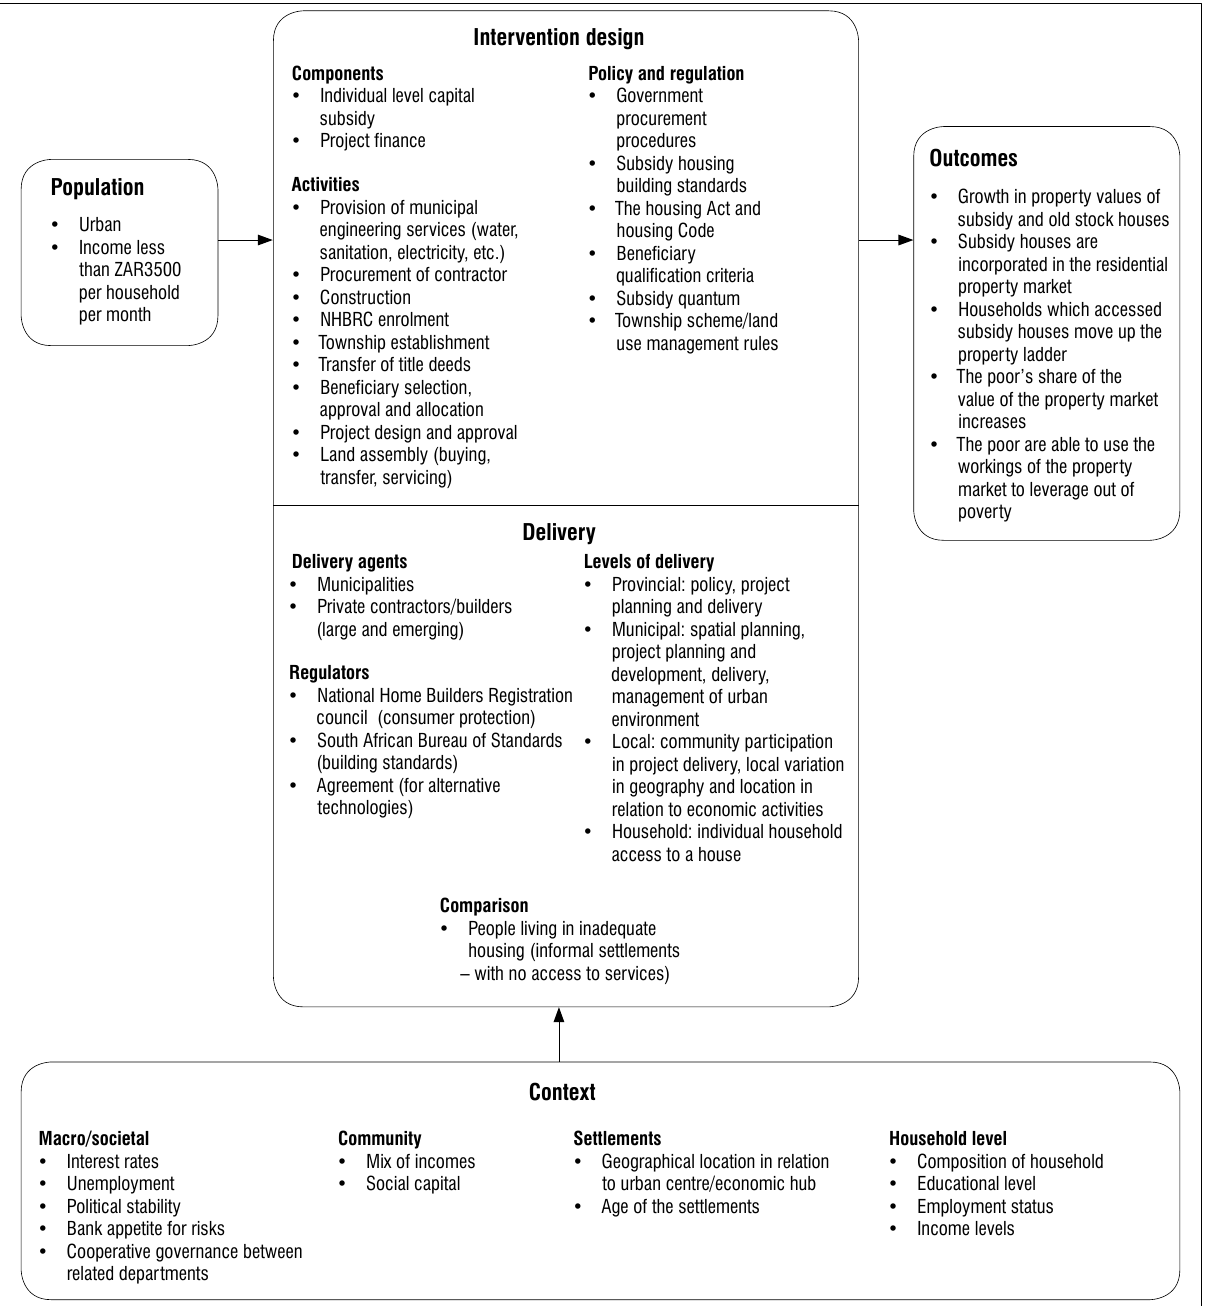
figure 1: Population-intervention-comparison-outcome-context: assessing whether the Housing Subsidy Programme created assets through the ownership